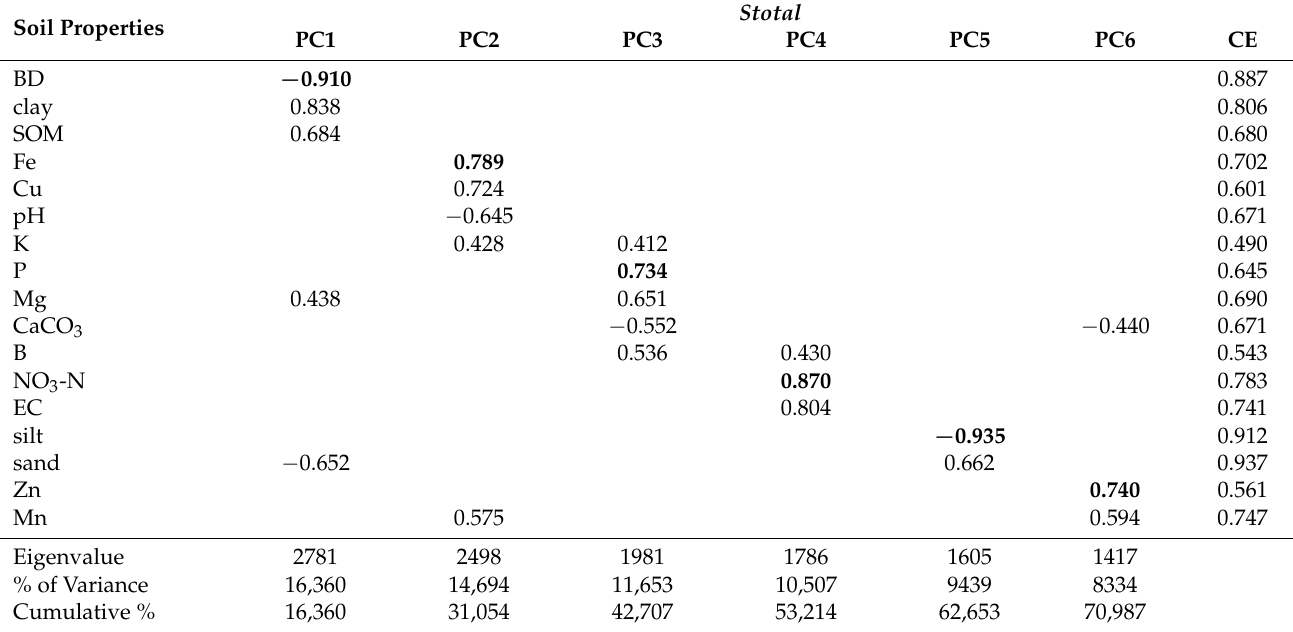
Table 3. Results of the principal component (PC) analysis of soil properties in the total study area ( Stotal